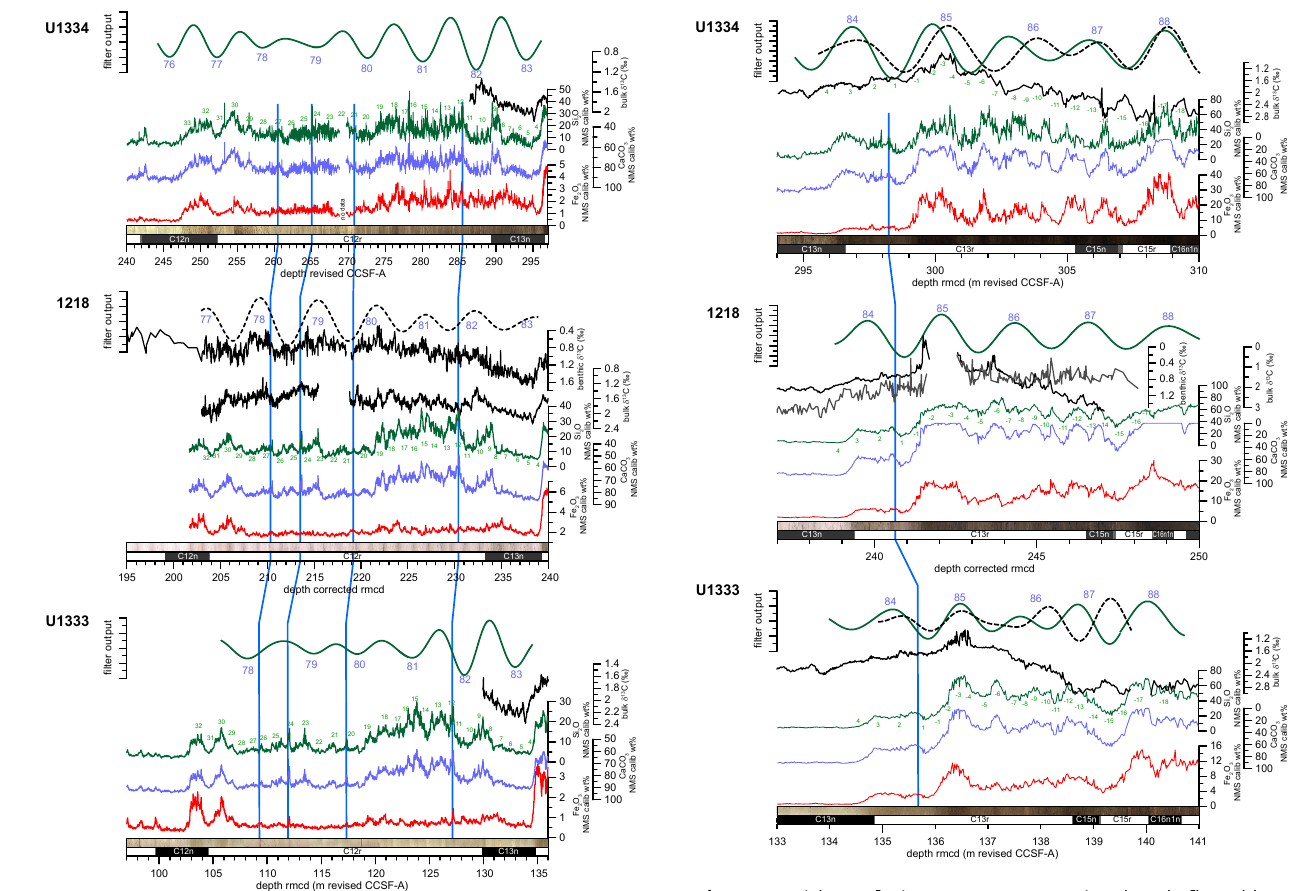
Figure 3. High-resolution XRF core scanning data, bulk and ben- thic stable carbon isotope data, core images and cyclostratigraphy from Chron C12n to C13n for Sites U1334, 1218, and U1333 in the depth domain. For details see captions of Fig. 2. Blue lines mark early Oligocene ash layers apparent in all three sites (Kuroda and and Westerhold, 2013). Numbers represent the assigned short (green) and long (blue) eccentricity cycle maxima positions in the orbital solution (see Supplement Fig. S8). Band pass filters: for Site U1334 from Si data (0 . 14 ± 0 . 042cyclemeter − 1 (cm − 1 ), 7.2m band in Supplement Fig. S2a), for Site 1218 from benthic stable car- bon isotope data (0 . 164 ± 0 . 049cm − 1 ), and for Site U1333 from Si data (0 . 2 ± 0 . 06cm − 1 ; 5m band in Supplement Fig. S2c).